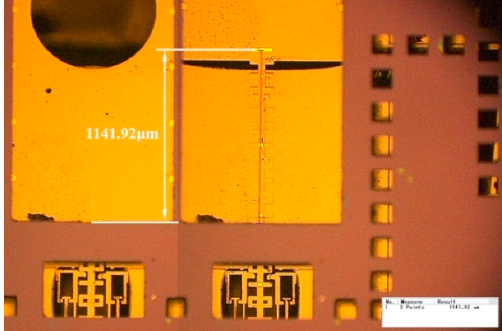
Figure 15. The travel range of interrupter in the S&A chip.